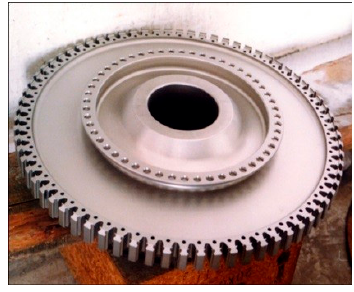
Figure 1. Structure of turbine disk.